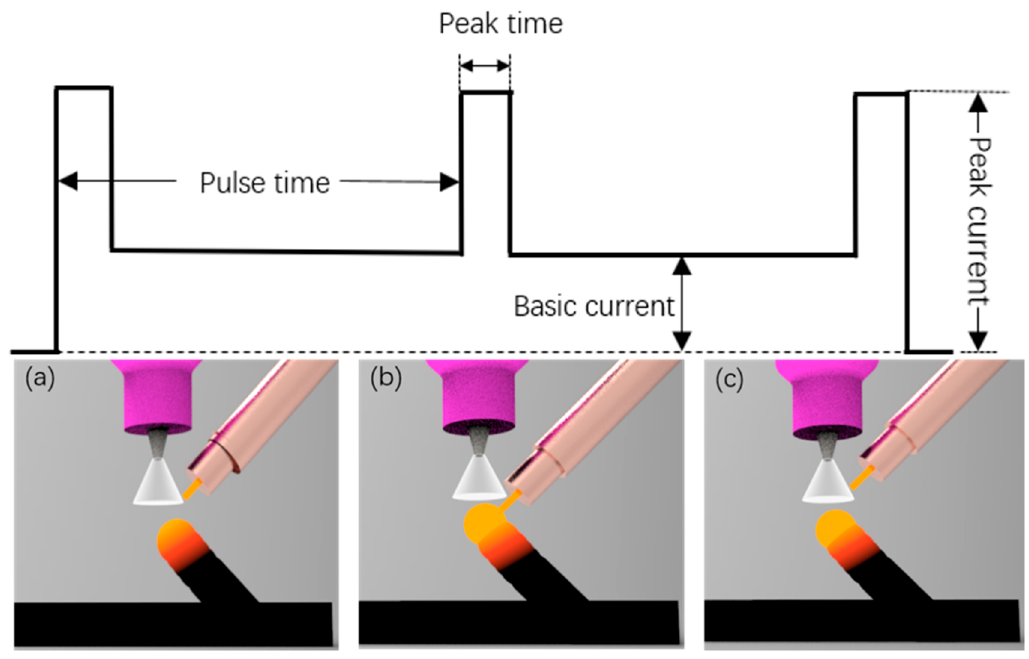
Figure 2. Deposition process of wire arc additive manufacturing of ( a , c ) the droplet shapes in the base current period, and ( b ) droplets transfer during peak current period.